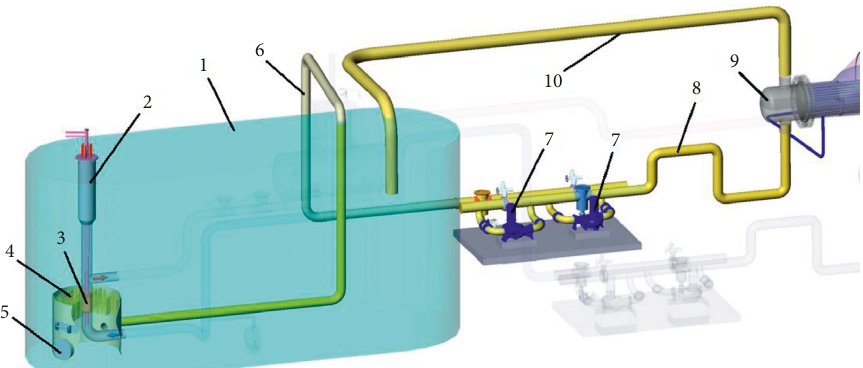
Figure 8: Principle of the pool cooling circuit (PCC), which removes heat from the reflector and irradiators. (1) reactor pool; (2) reactor vessel; (3) core; (4) neutron reflector; (5) natural circulation valve through the reflector; (6) outlet “hot” pipeline; (7) circulation pumps; (8) pressure pipeline of pumps; (9) steam generator; (10) chilled water return pipeline to the